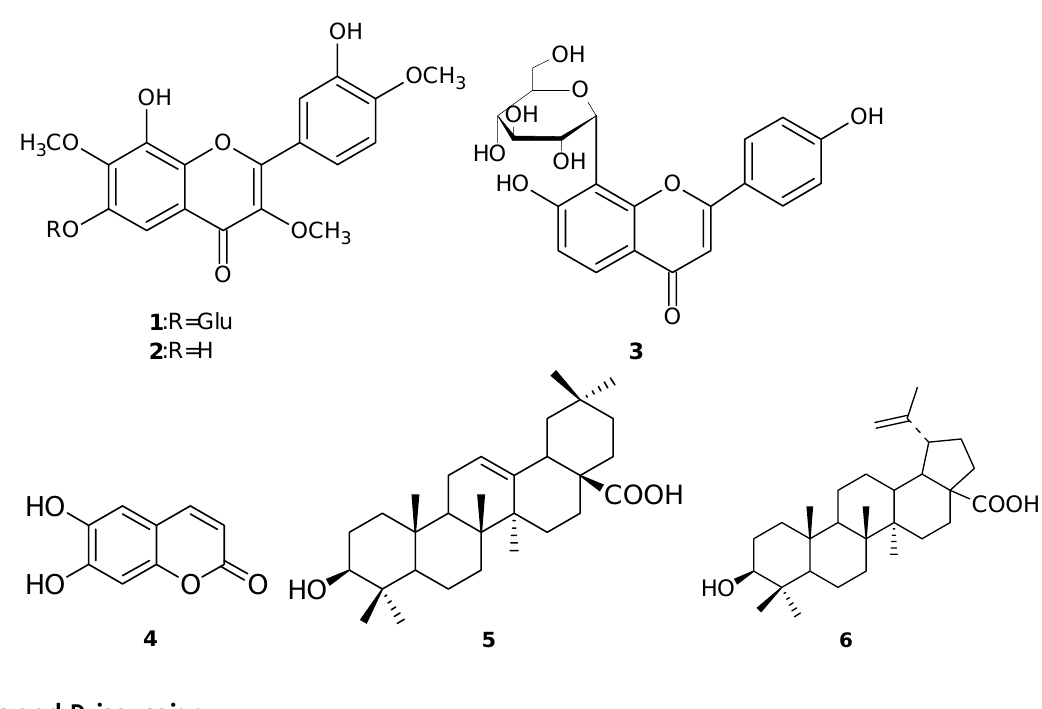
Figure 1. Structures of compounds 1-6